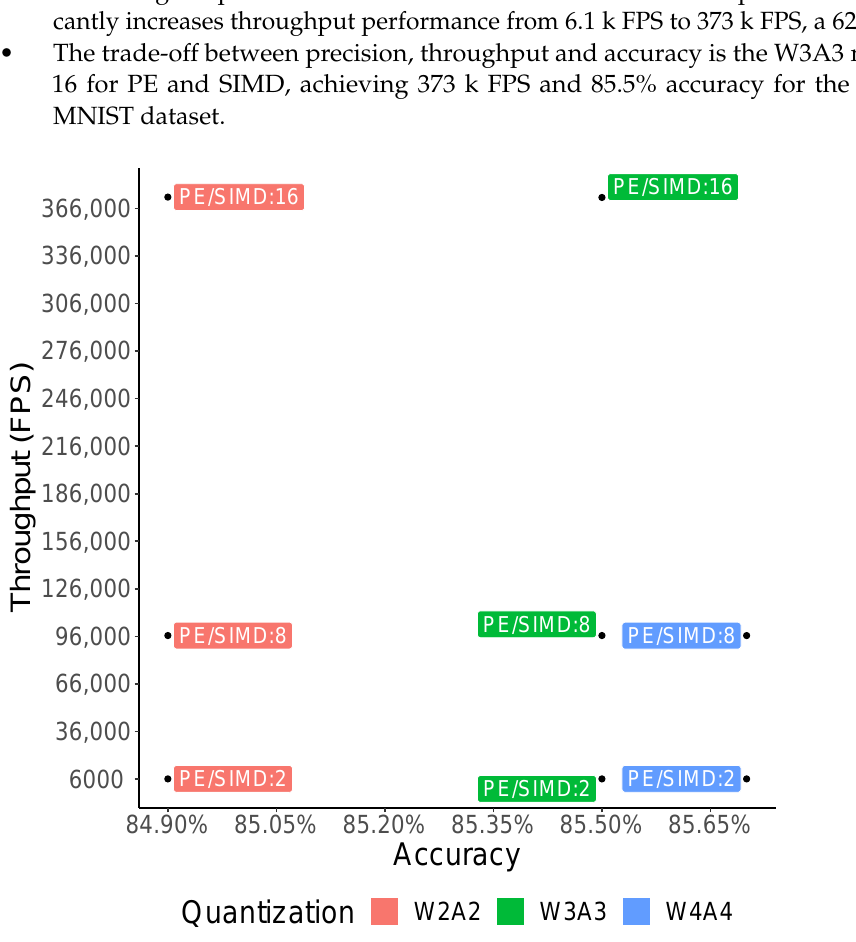
Figure 8. Throughput and accuracy performance of parallel FPGA designs for